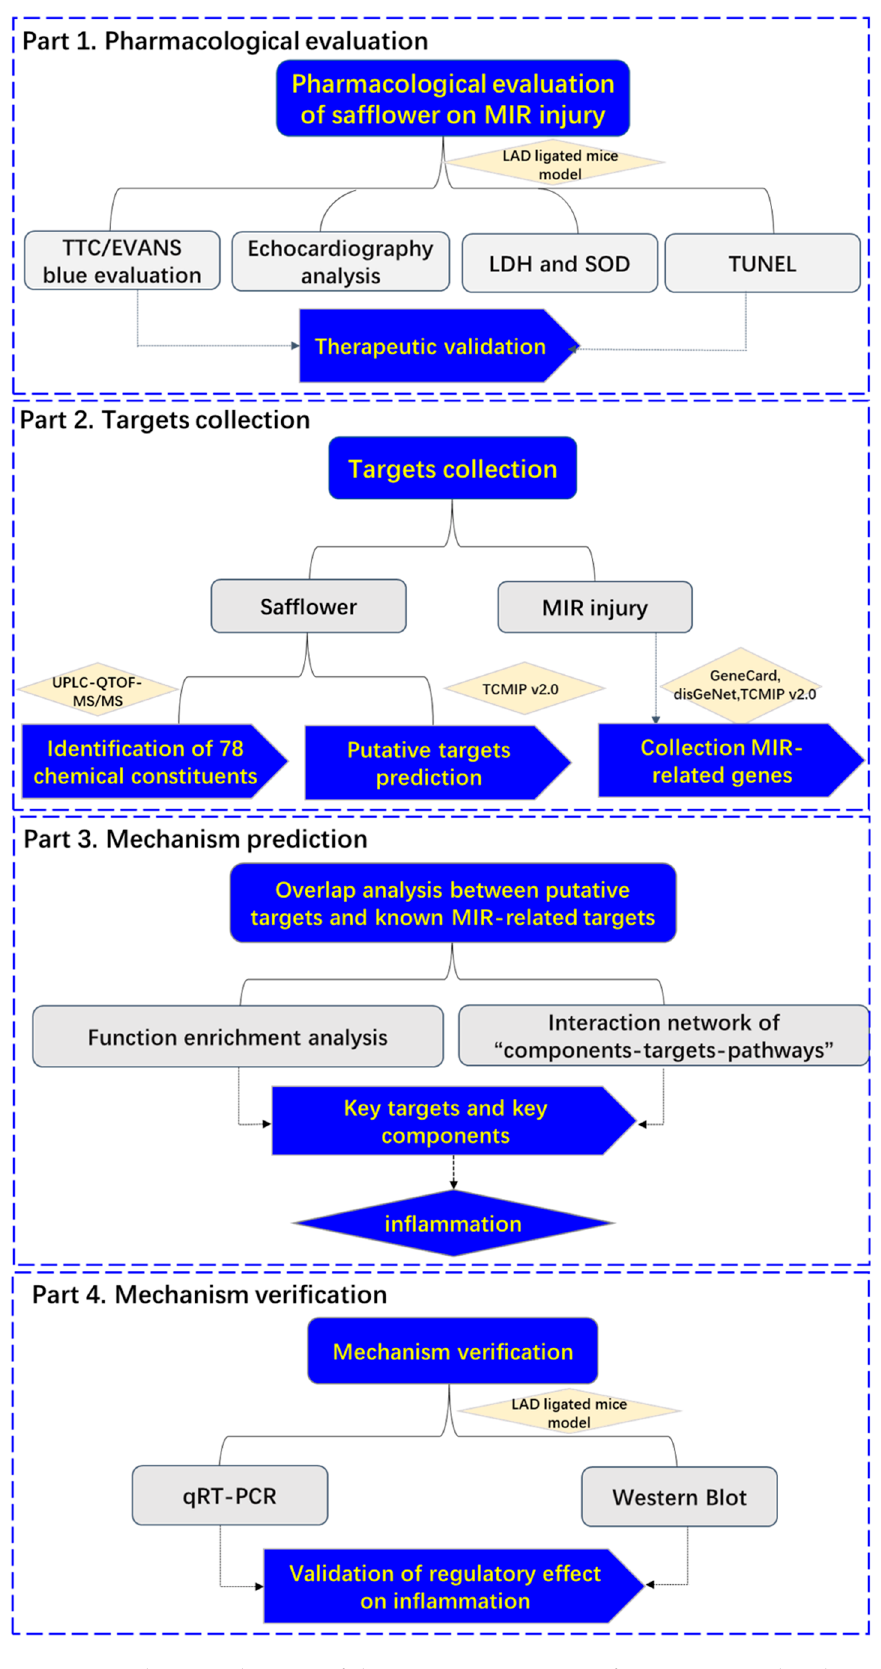
Figure 1. A schematic diagram of the systematic strategies for uncovering the pharmacological mechanisms of safflower action on MIR injury.